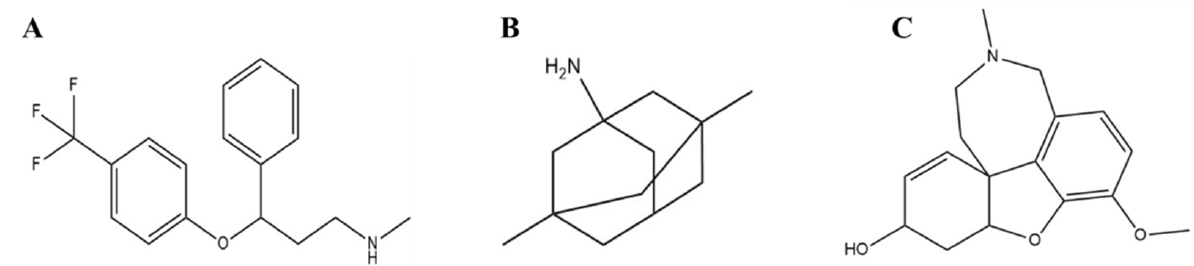
Figure 1. Two-dimensional structures of ( A ) Fluoxetine, ( B ) Memantine and ( C ) Galantamine.